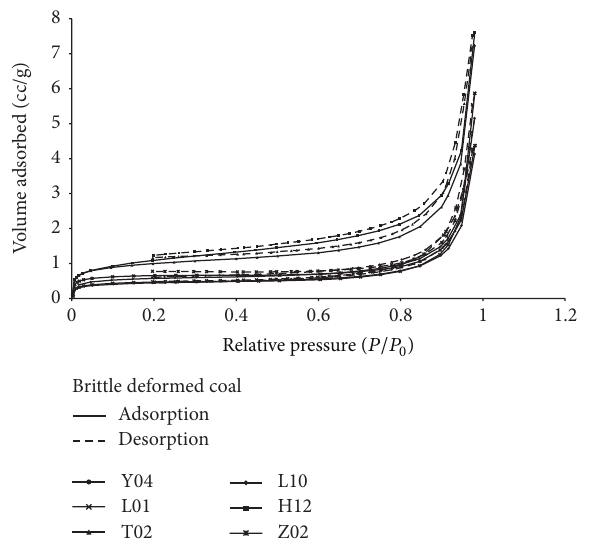
Figure 4: N 2 gas adsorption/desorption isothermals of six ductile deformed